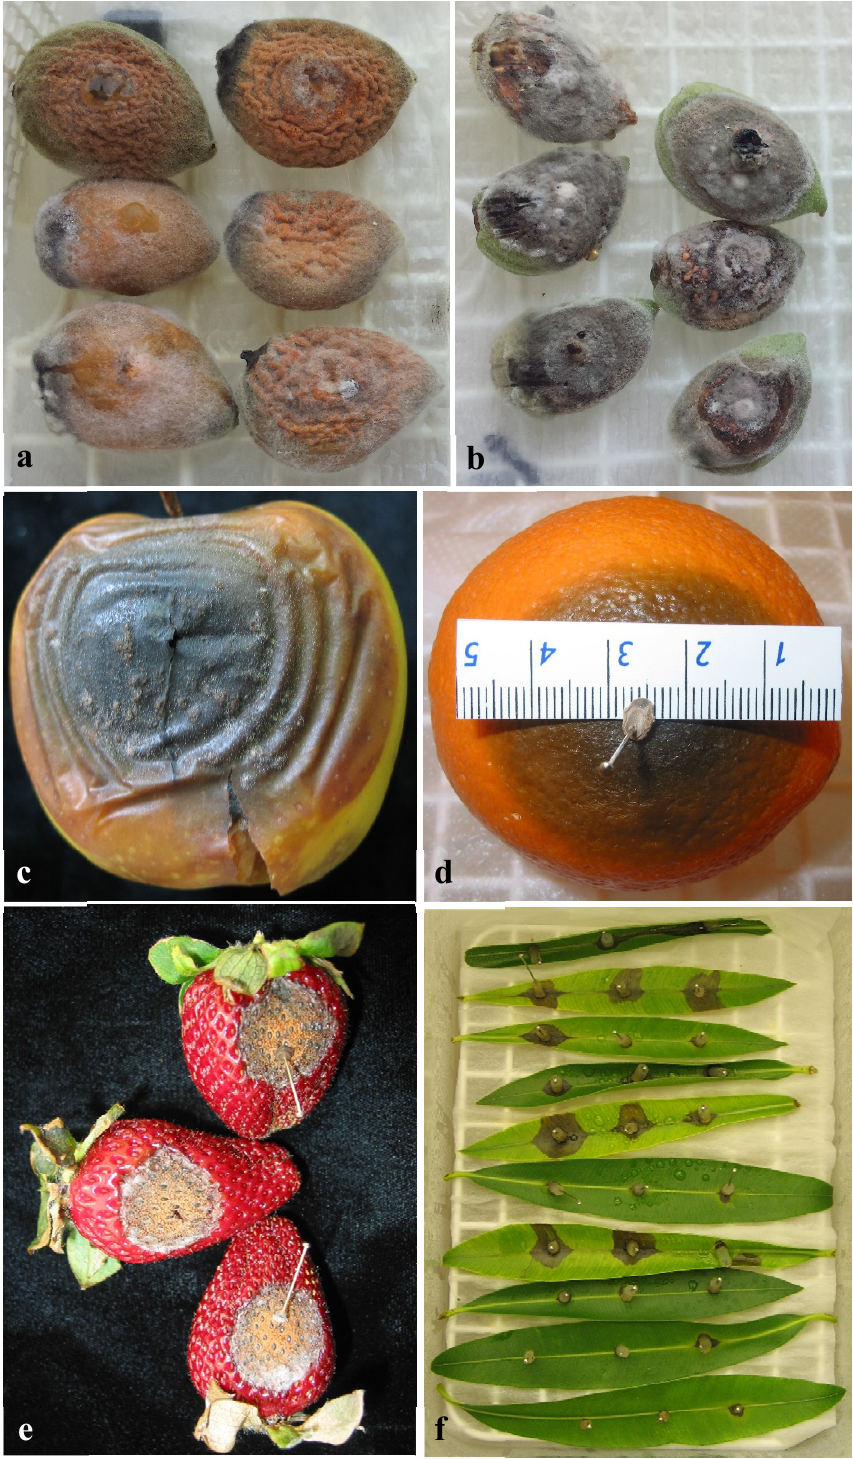
Figure 10. Anthracnose symptoms developed on fruit or leaves of several hosts 14 days after inoculation with a conidial suspension of Colletrotrichum isolates. ( a , b ) almond cv. Guara inoculated with C. acutatum from almonds (Col-536) and C. godetiae from almonds (Col-522) ( c ) apple cv. Golden Delicious inoculated with C. gloeosporioides from sweet oranges (Col-69); ( d ) sweet orange cv. Lane Late inoculated with C. gloeosporioides from sweet oranges (Col-69); ( e ) strawberry cv. Camarosa inoculated with C. godetiae from strawberries (Col-57); ( f ) leaves of Nerium oleander inoculated with C. gloeosporioides from sweet oranges (Col-69).